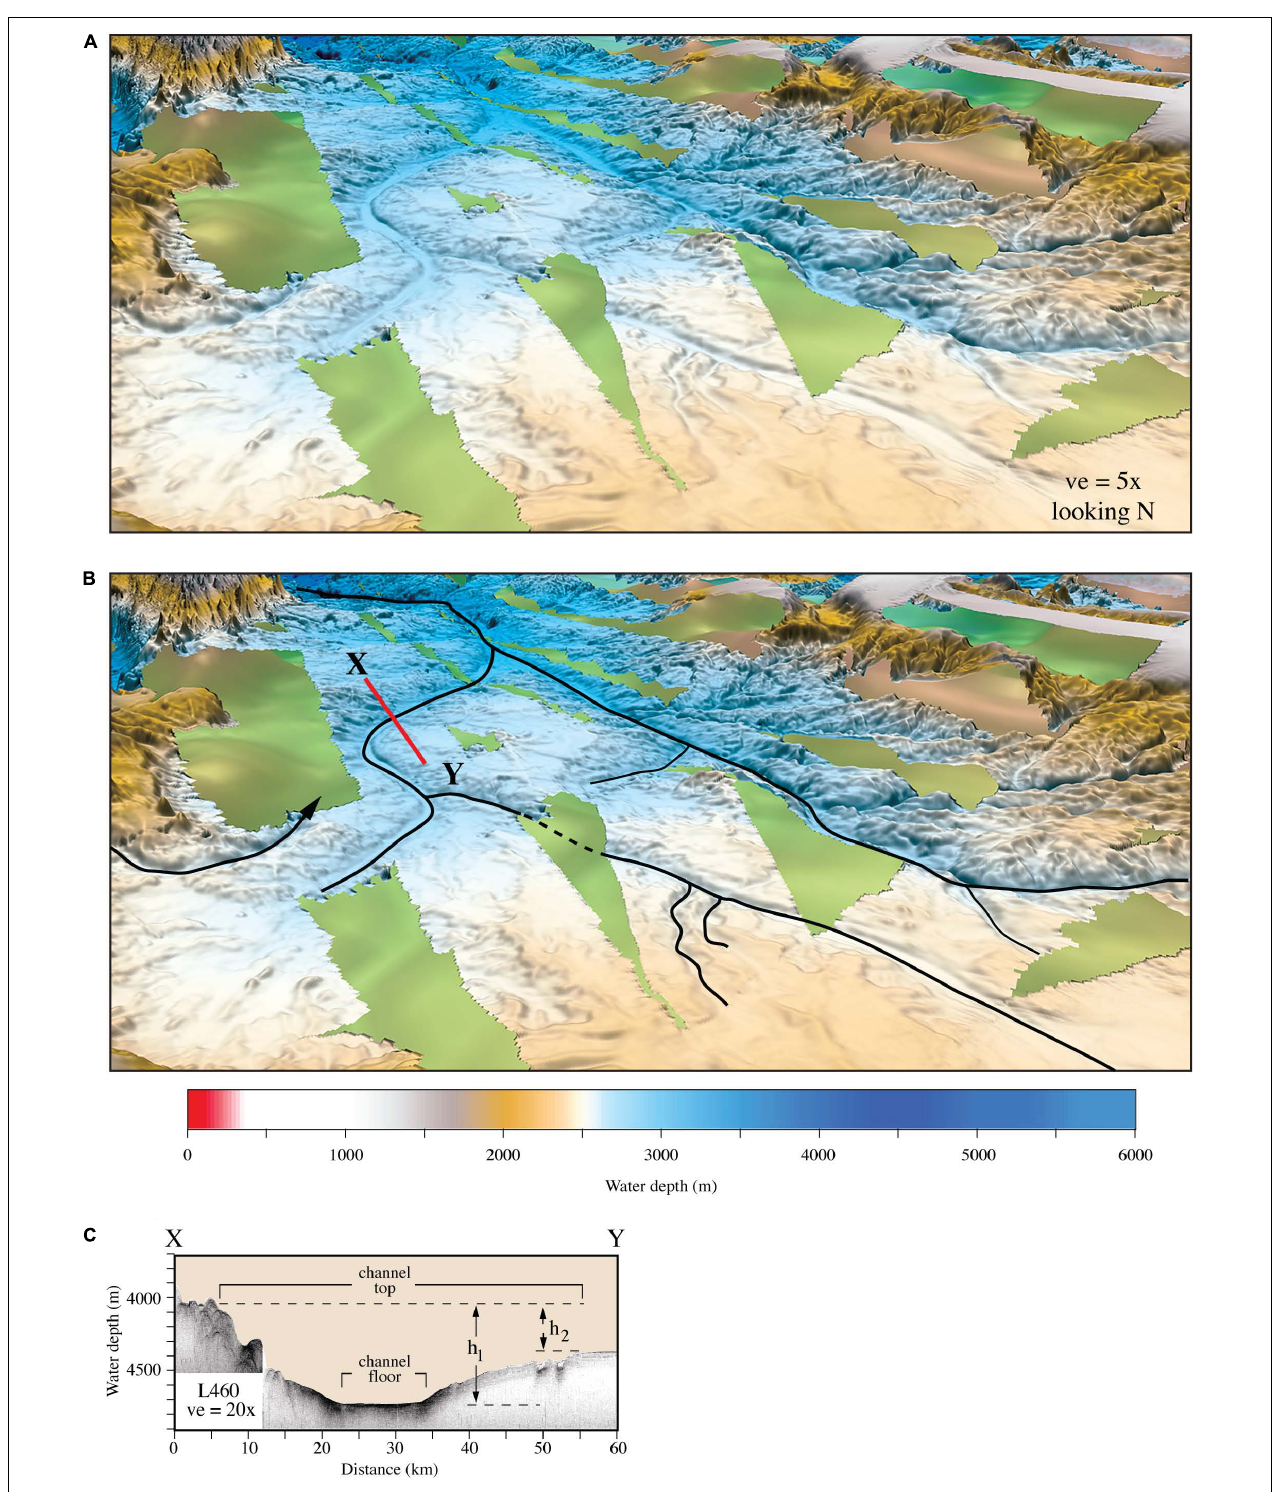
FIGURE 2 | (A) Perspective view of a typical area of northern Line Islands Ridge that shows the smooth channel floors and linear to curvilinear nature of the channel reaches compared to the otherwise rough seafloor (only representative tributaries are shown). Locations and look direction shown as black bracket on Figure 3 . Approximate dimensions of image are 105 m top to bottom and 85 km left to right. (B) Same view as (A) with channels outlined in solid black lines, dashed where assumed continuation where no MBES coverage. Red line is location of subbottom profile XY. (C) Subbottom seismic profile across a channel. Channel relief calculated as (h 1 -h 2